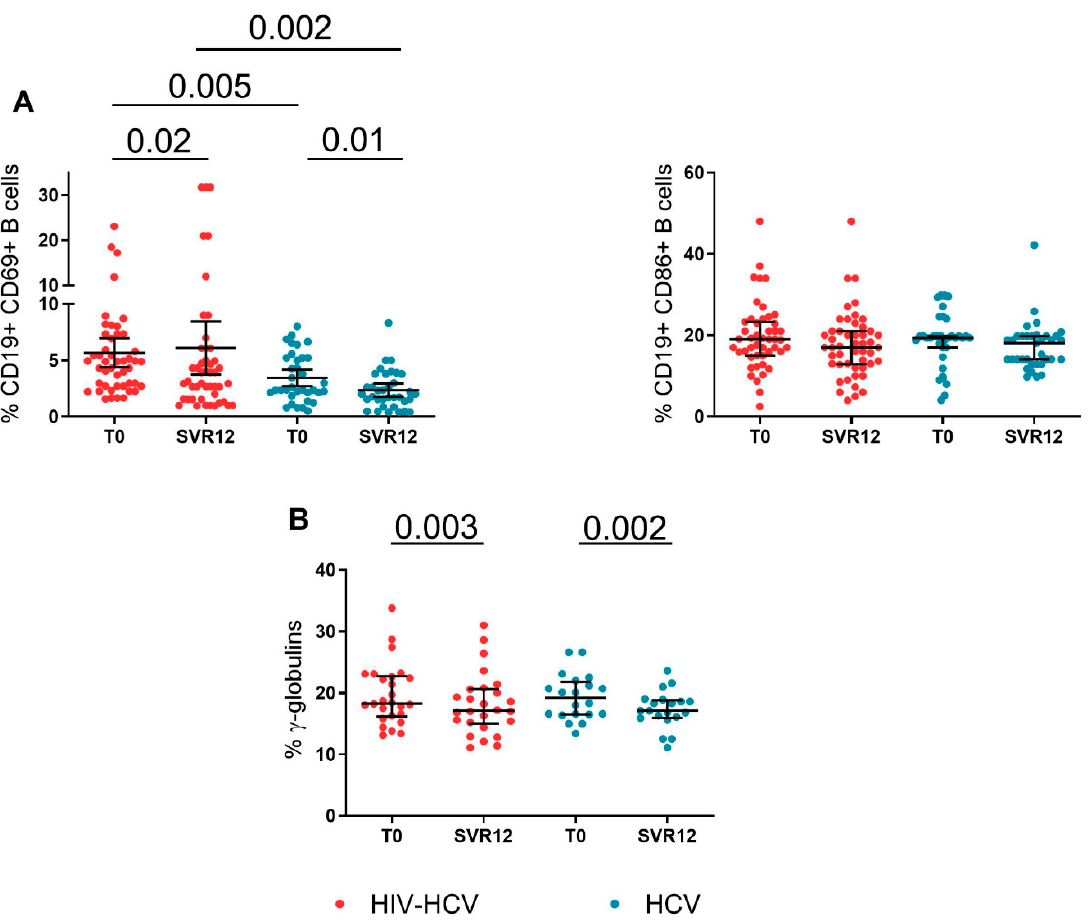
Figure 3. B-cell activation and γ -globulins in the HIV-HCV co-infected and HCV mono-infected individuals that were undergoing DAA treatment. ( A ) Frequencies of activated CD69+ and CD86+ B-cells in the HIV-HCV co-infected and HCV mono-infected individuals prior and following DAA treatment. Wilcoxon matched-pairs test ( n = 47 and n = 35) and Mann–Whitney test. ( B ) γ -globulins in the HIV-HCV co-infected and HCV mono-infected individuals prior and following DAA treatment. Wilcoxon matched-pairs test ( n = 26 and n = 20) and Mann–Whitney test.